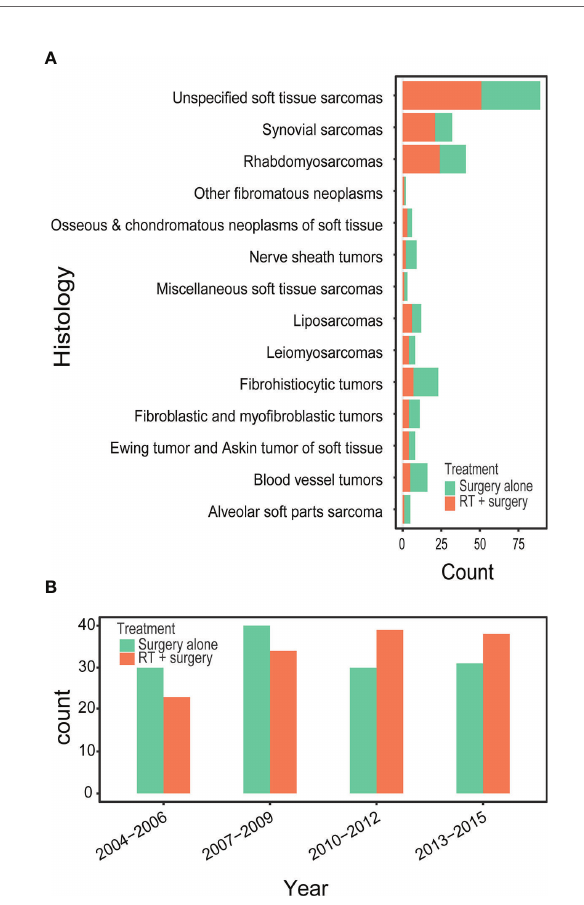
FIGURE 2 | Bar diagram illustrating the treatment for patients with RSTS- RLNM in different histology (A) and over different diagnosis year (B) in an original unmatched cohort from the SEER database.